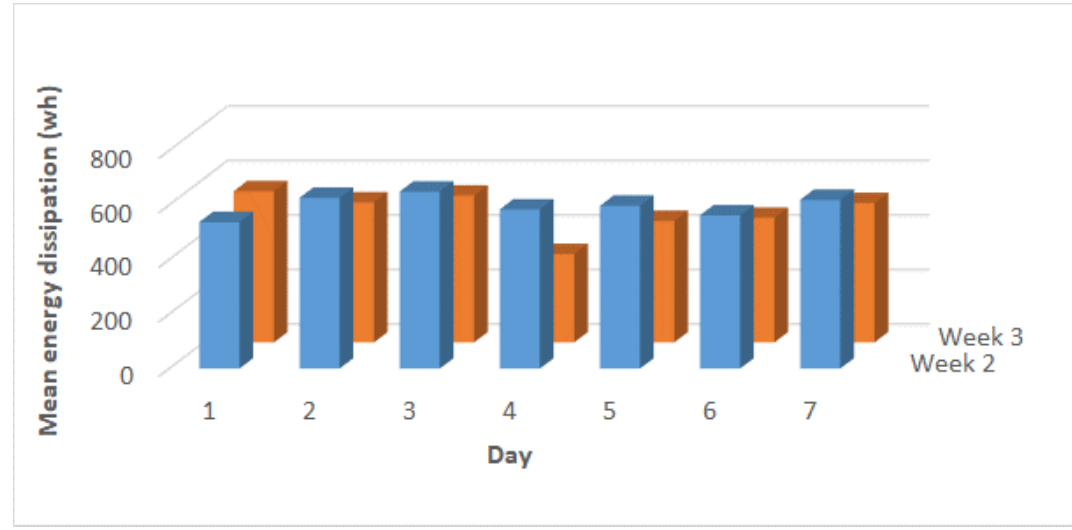
Figure 10. Mean energy dissipation, experiment 2.